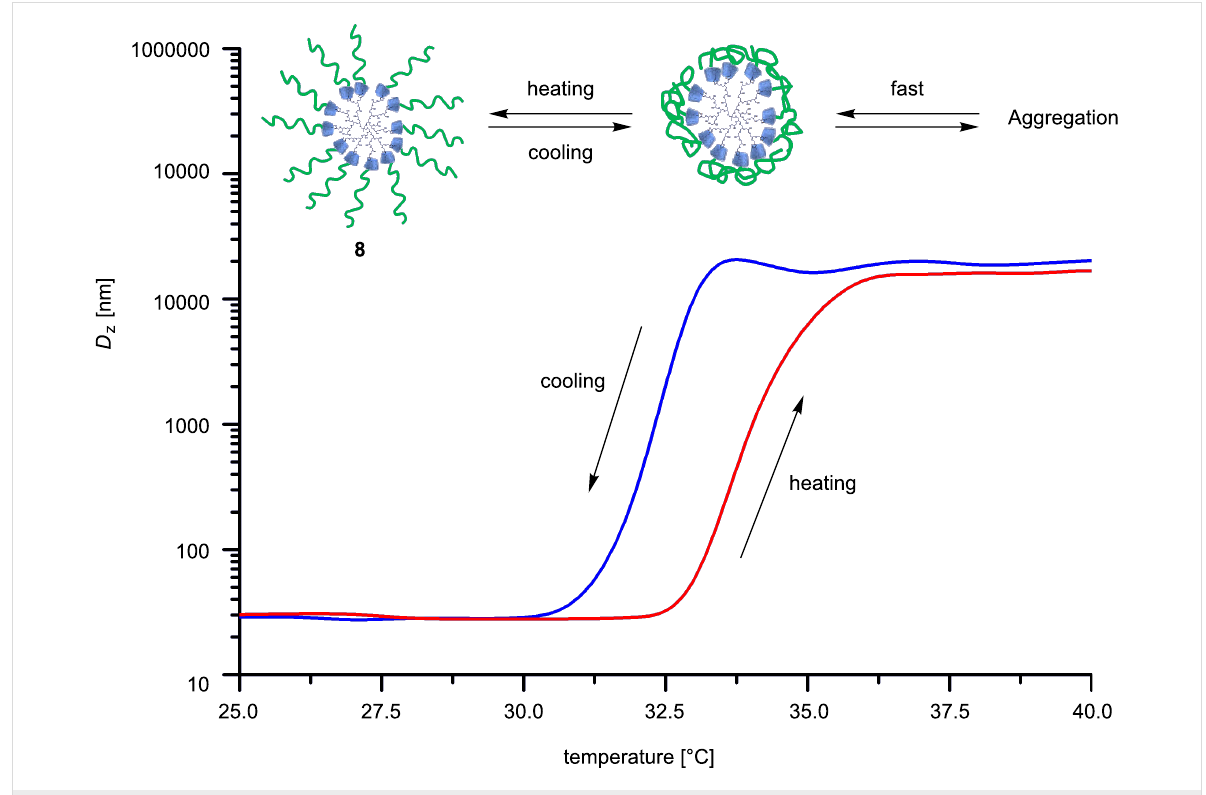
Figure 4: z-Average diameter ( D Z ) of the complex 8 in water as a function of temperature (0.5 mg/mL, heating rate 0.5 °C/min).